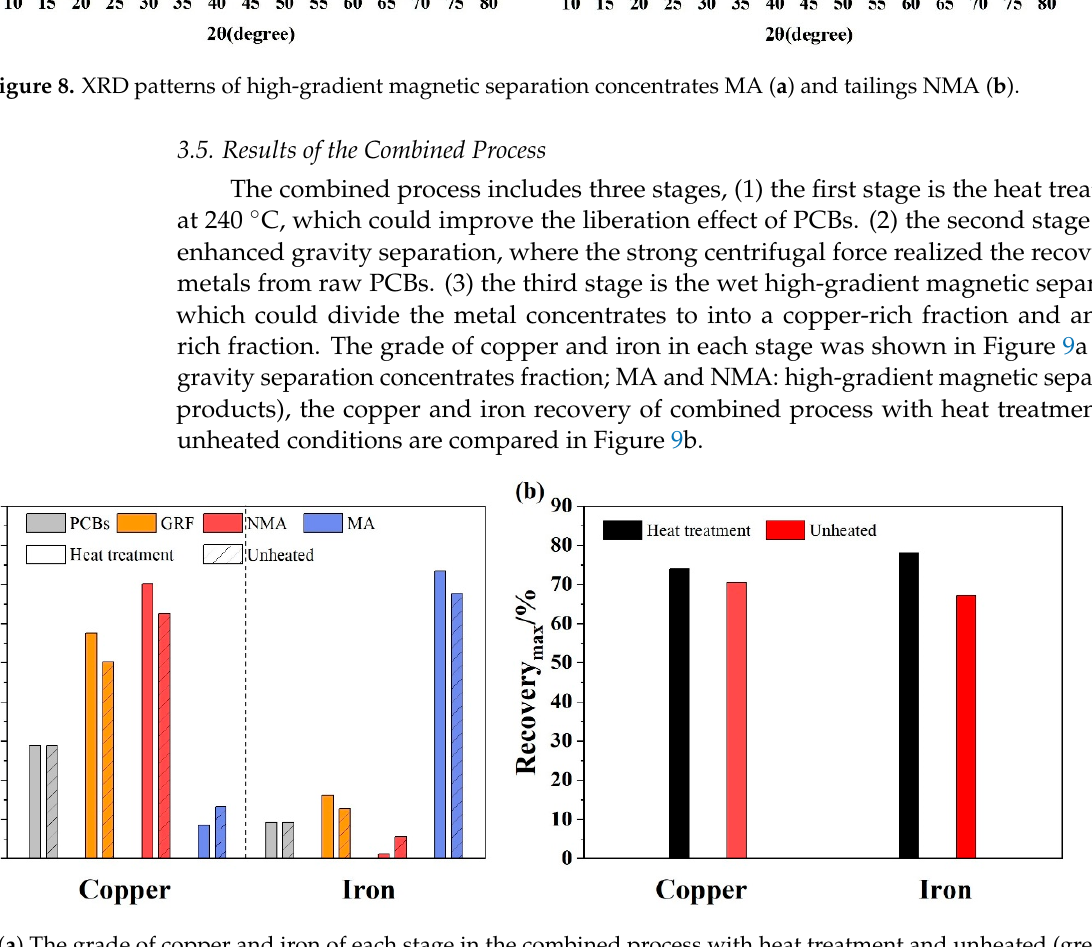
Figure 9. ( a ) The grade of copper and iron of each stage in the combined process with heat treatment and unheated (grey diagonal stripe) conditions; ( b ) The copper and iron recovery of the combined process.